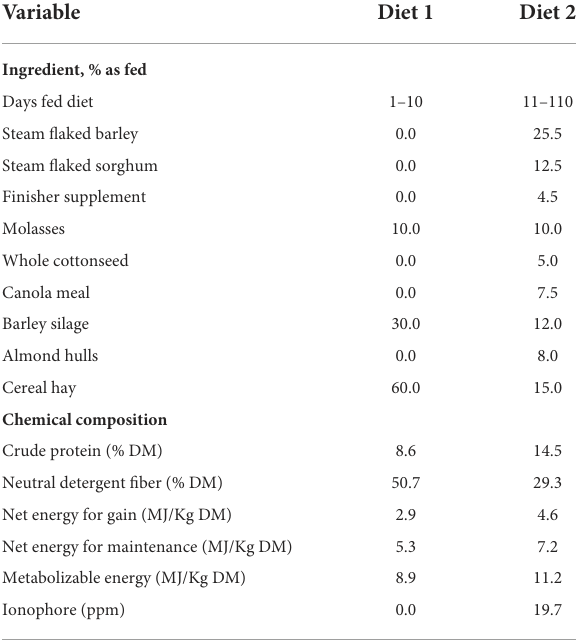
during backgrounding was 11.2 and 10.2% CP, 55.0 and 53.7% TABLE 1 Dietary ingredient and nutrient compositions of the feedlot finishing